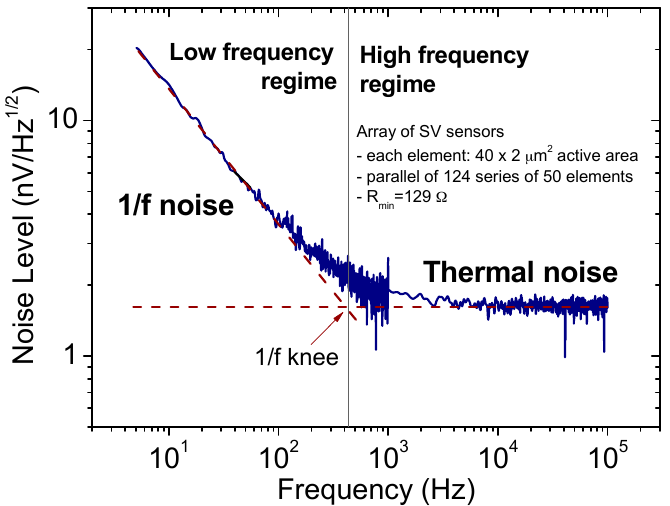
Figure 2. Typical noise spectrum of a MR device (SV array), reaching the thermal level for frequencies around 400 Hz. In the low frequency regime the 1/ f noise is dominant, while in the high frequency regime the spectrum is reduced to its thermal level. Both electronic and magnetic noise components are present since the spectrum was recorded with the sensor operating on its linear range.